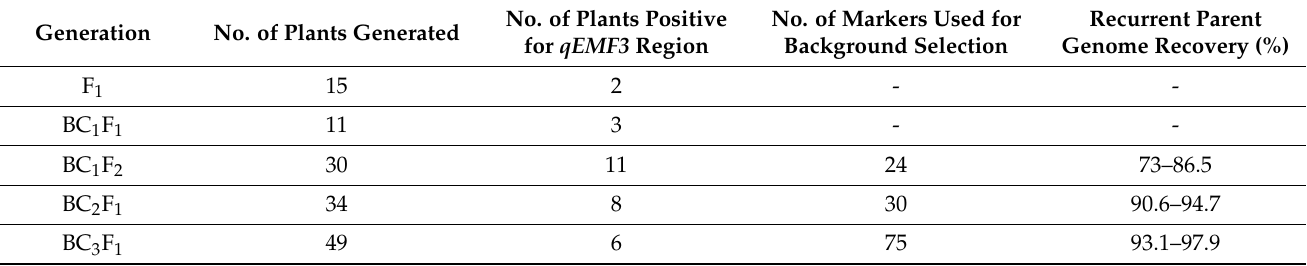
Figure 2. Flowering pattern of the rice genotypes: ( a ) first and peak flowering of CO 51, IR64 and IR64- qEMF3 ; ( b ) diurnal variations in the anthesis patterns of CO 51, IR64 and IR64- qEMF3 and the corresponding air temperature; and ( c ) spikelet sterility %. Table 2. Number of backcross progenies evaluated and their recurrent parent genome